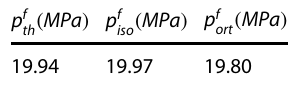
Table 1 Theoretical and numerical burst